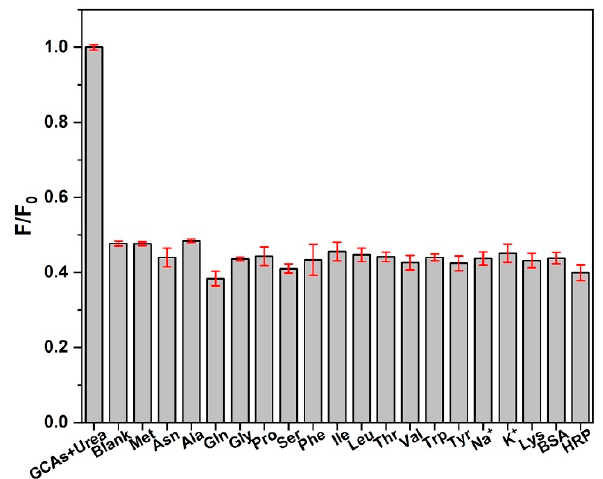
Figure 6. The selectivity of the established sensing system to coexisting interference substances. 0.5